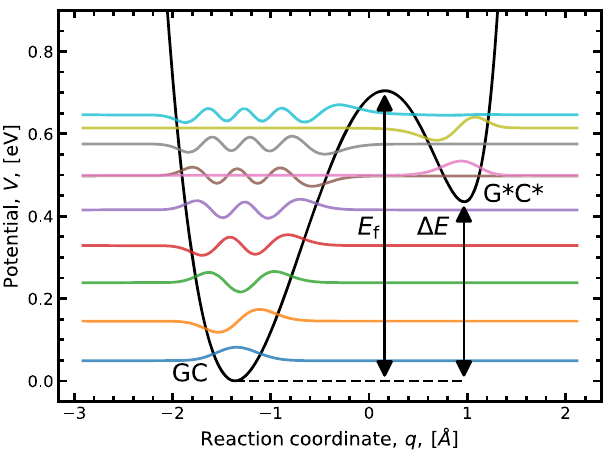
Fig. 2 Proton transfer potential energy landscape. The coloured horizontal lines denote the fi rst ten eigenstates. The fi rst eigenstate energy is E = 0.049 eV, the forward reaction barrier E 0 asymmetry between the canonical and tautomeric form Δ E = 0.435